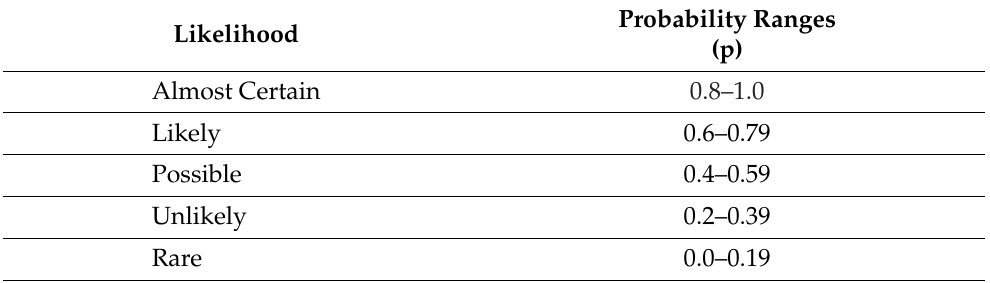
Table 4. The classification of attack paths based on the probability ranges adapted from [36,37].